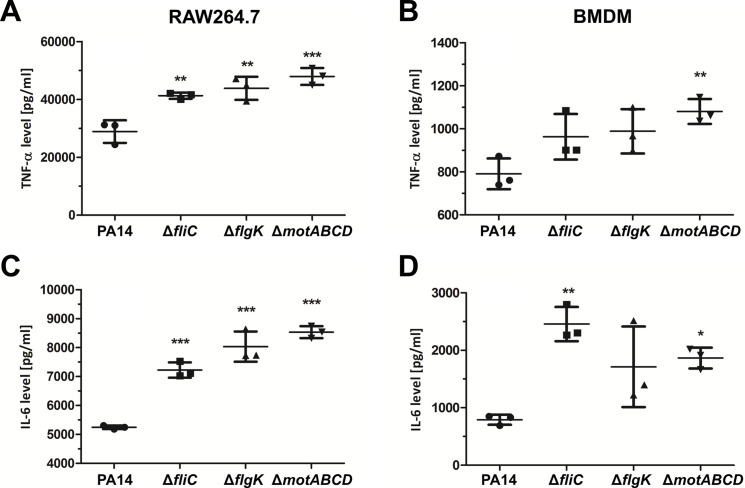
Cytokine measurement in the supernatant of infected macrophages using ELISA.TNF-α measurements of RAW264.7 (A) and BMDM cells (B) after 6 hr infection with P. aeruginosa at an MOI of 1. IL-6 measurements of RAW264.7 (C) and BMDM cells (D) after 6 hr infection with P. aeruginosa with an MOI of 1. Mean ± standard deviation of three representative biological replicates is displayed. *p<0.05; **p<0.01; ***p<0.001 (one-way analysis of variance (ANOVA), Dunnett’s post-hoc test).